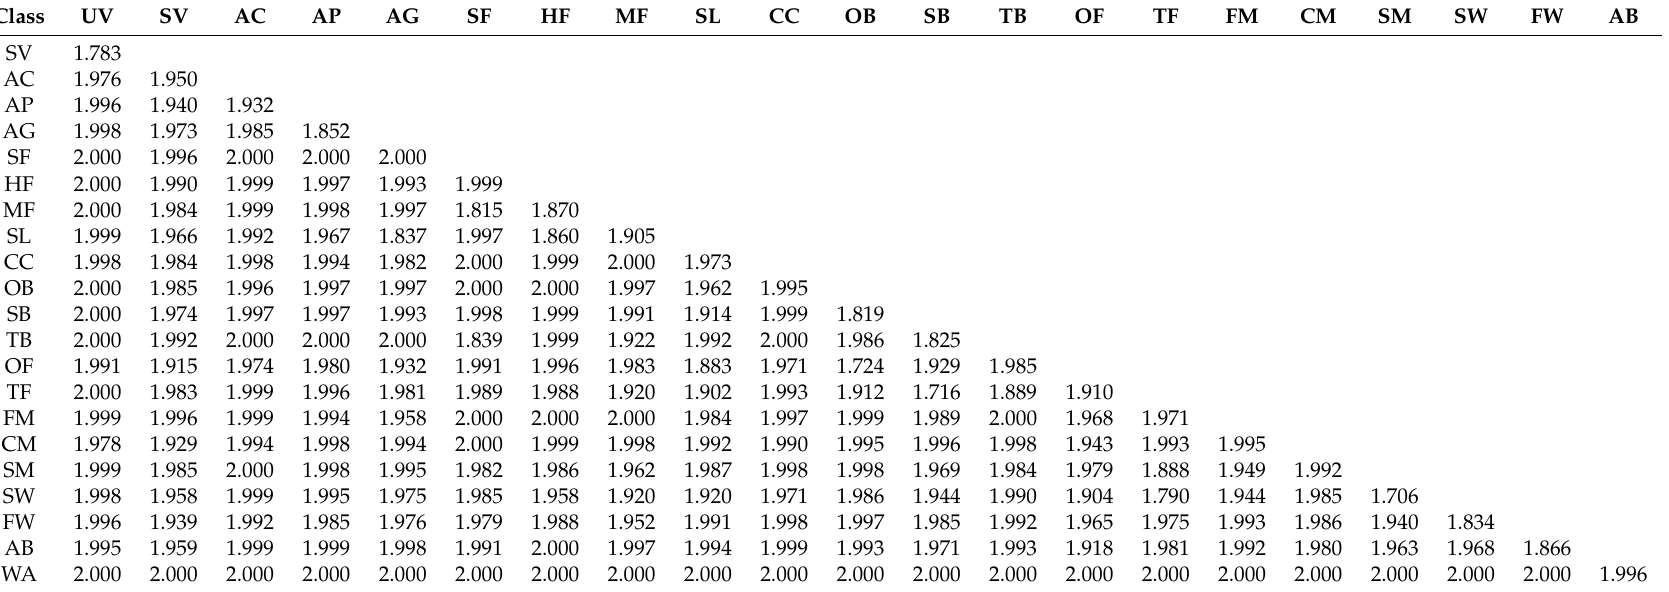
Table 8. J–M distances computed with the bands 2 to 6 of all the Landsat 8 OLI